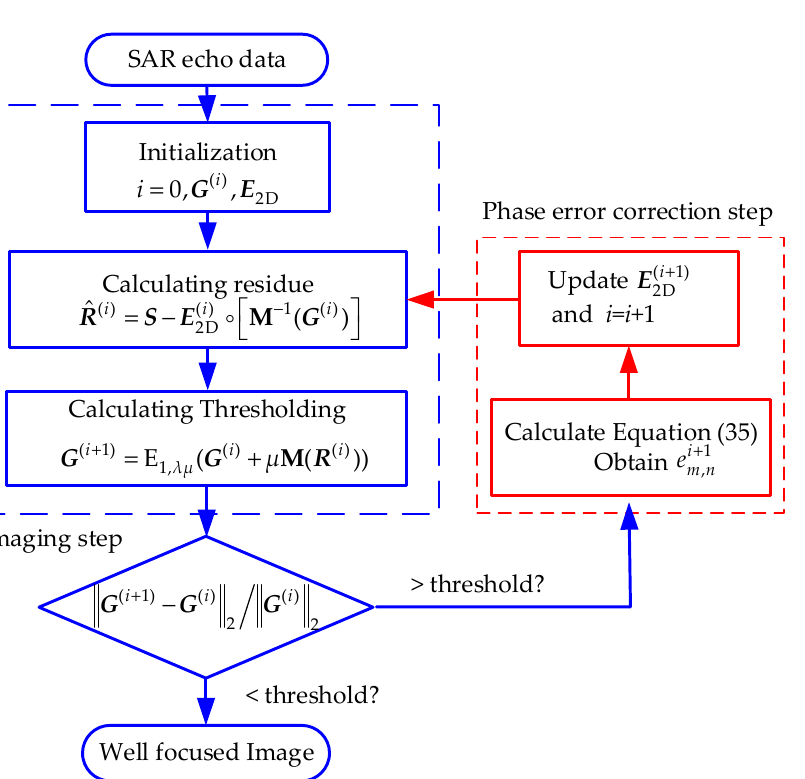
Figure 3. The overall flow chart of the entire sparse SAR imaging and motion error correction method.